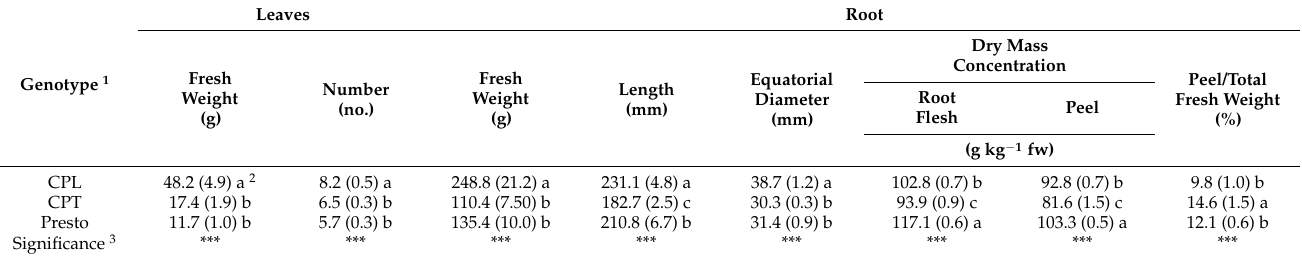
Table 1. Aerial part characteristics and root bio-morphological features of carrot genotypes.